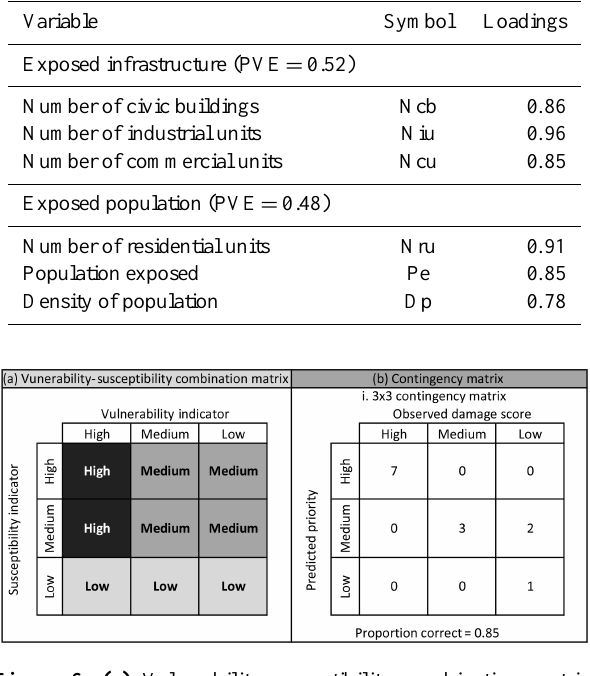
Figure 6. (a) Vulnerability–susceptibility combination matrix. (b) Contingency